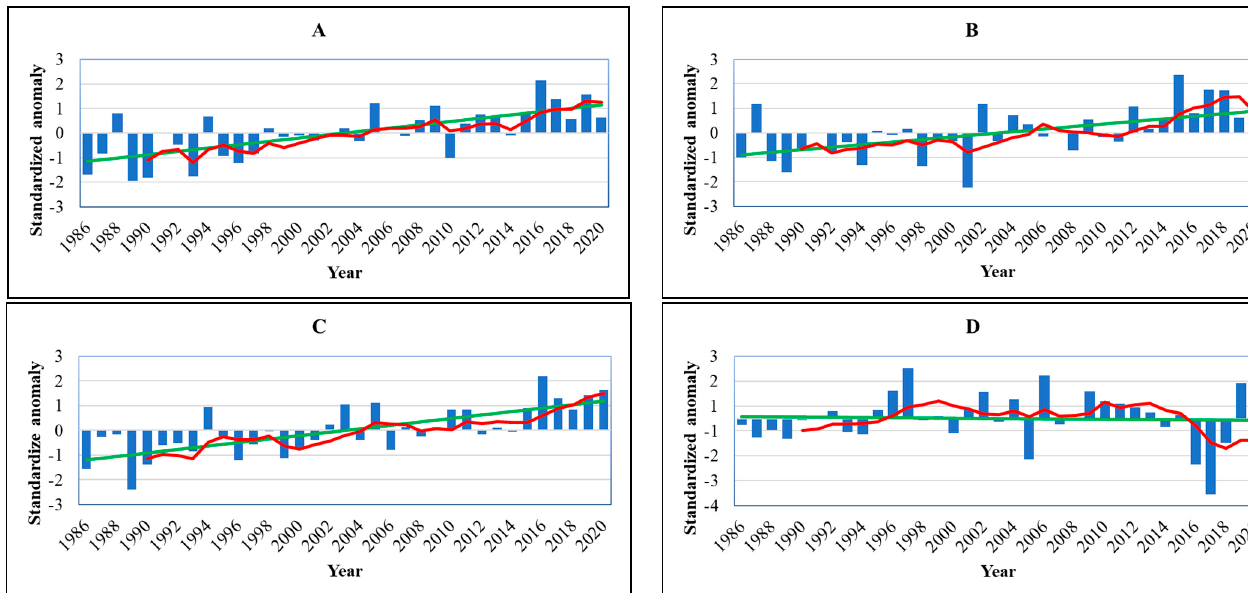
Figure 9. Time series diagram of the mean country-wide extreme temperature indices in the period between 1986 and 2020: ( A ) TXx, ( B ) TXn, ( C ) TNx, and ( D ) TNn. Note: The straight green line is the linear trend for the variables, while the red curved line is the five-year moving average.